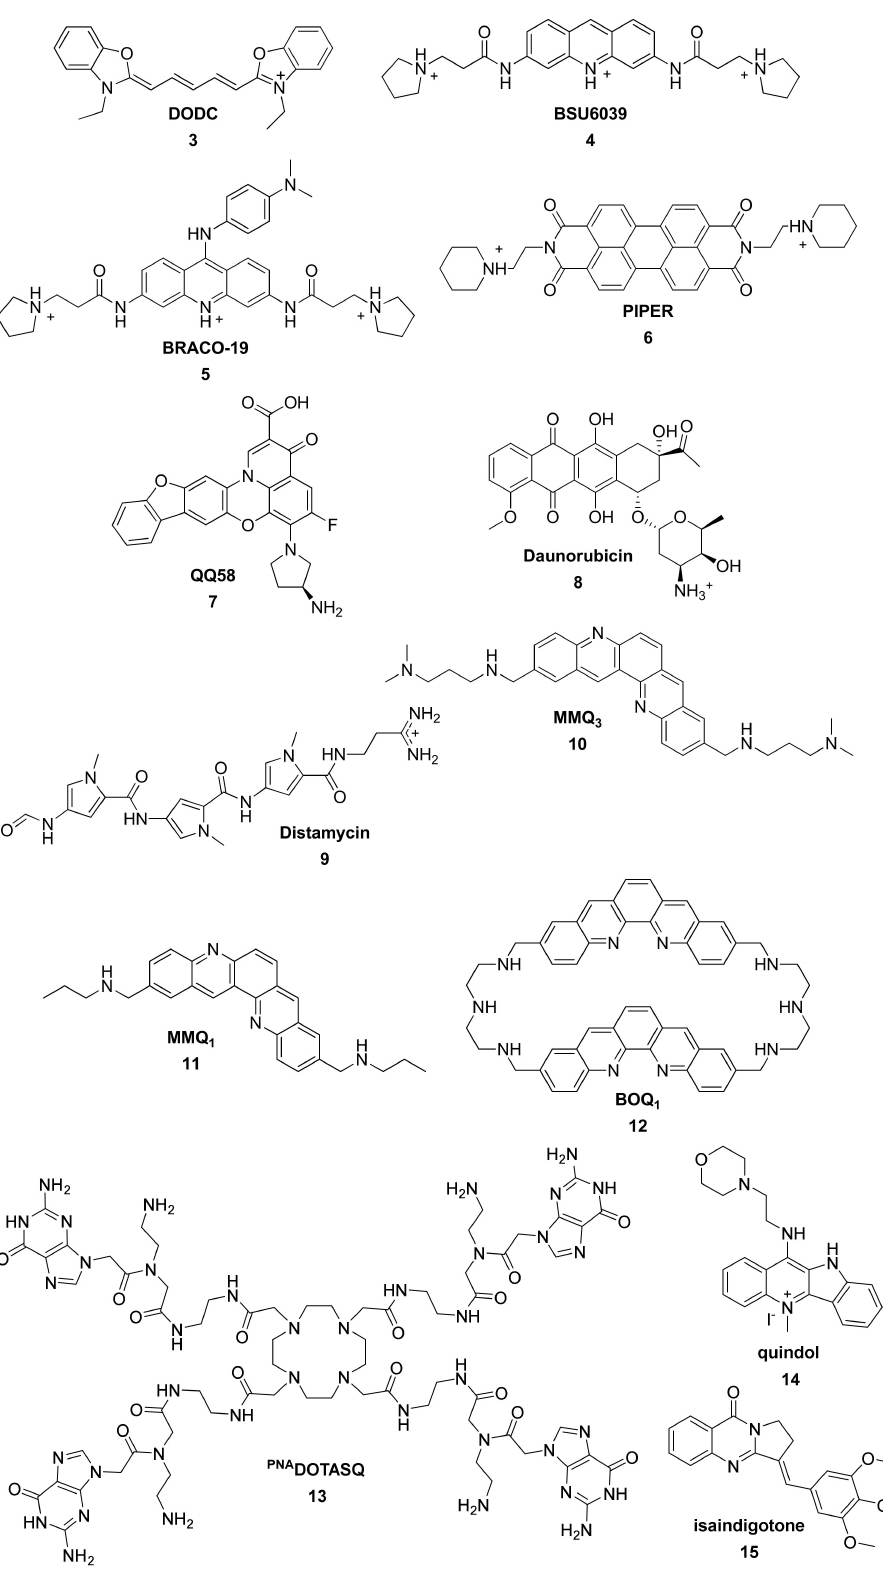
Figure 5. Structure of the in situ protonated ligands. 3 —DODC. 4 —BSU6039. 5